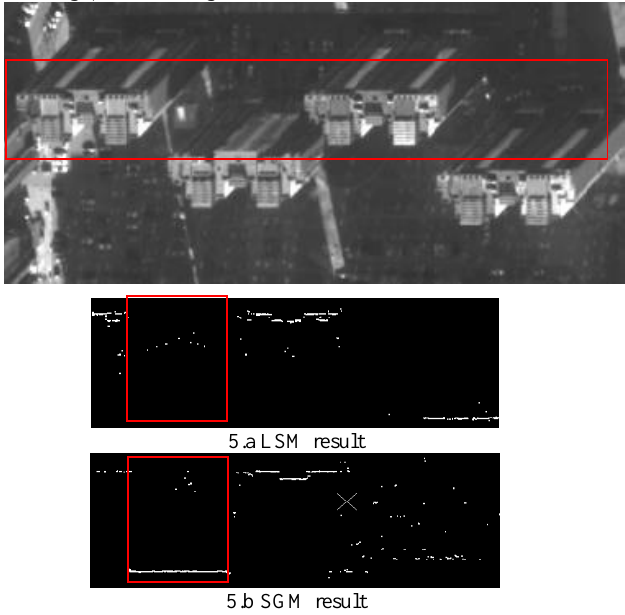
Figure 5. Comparison of results at